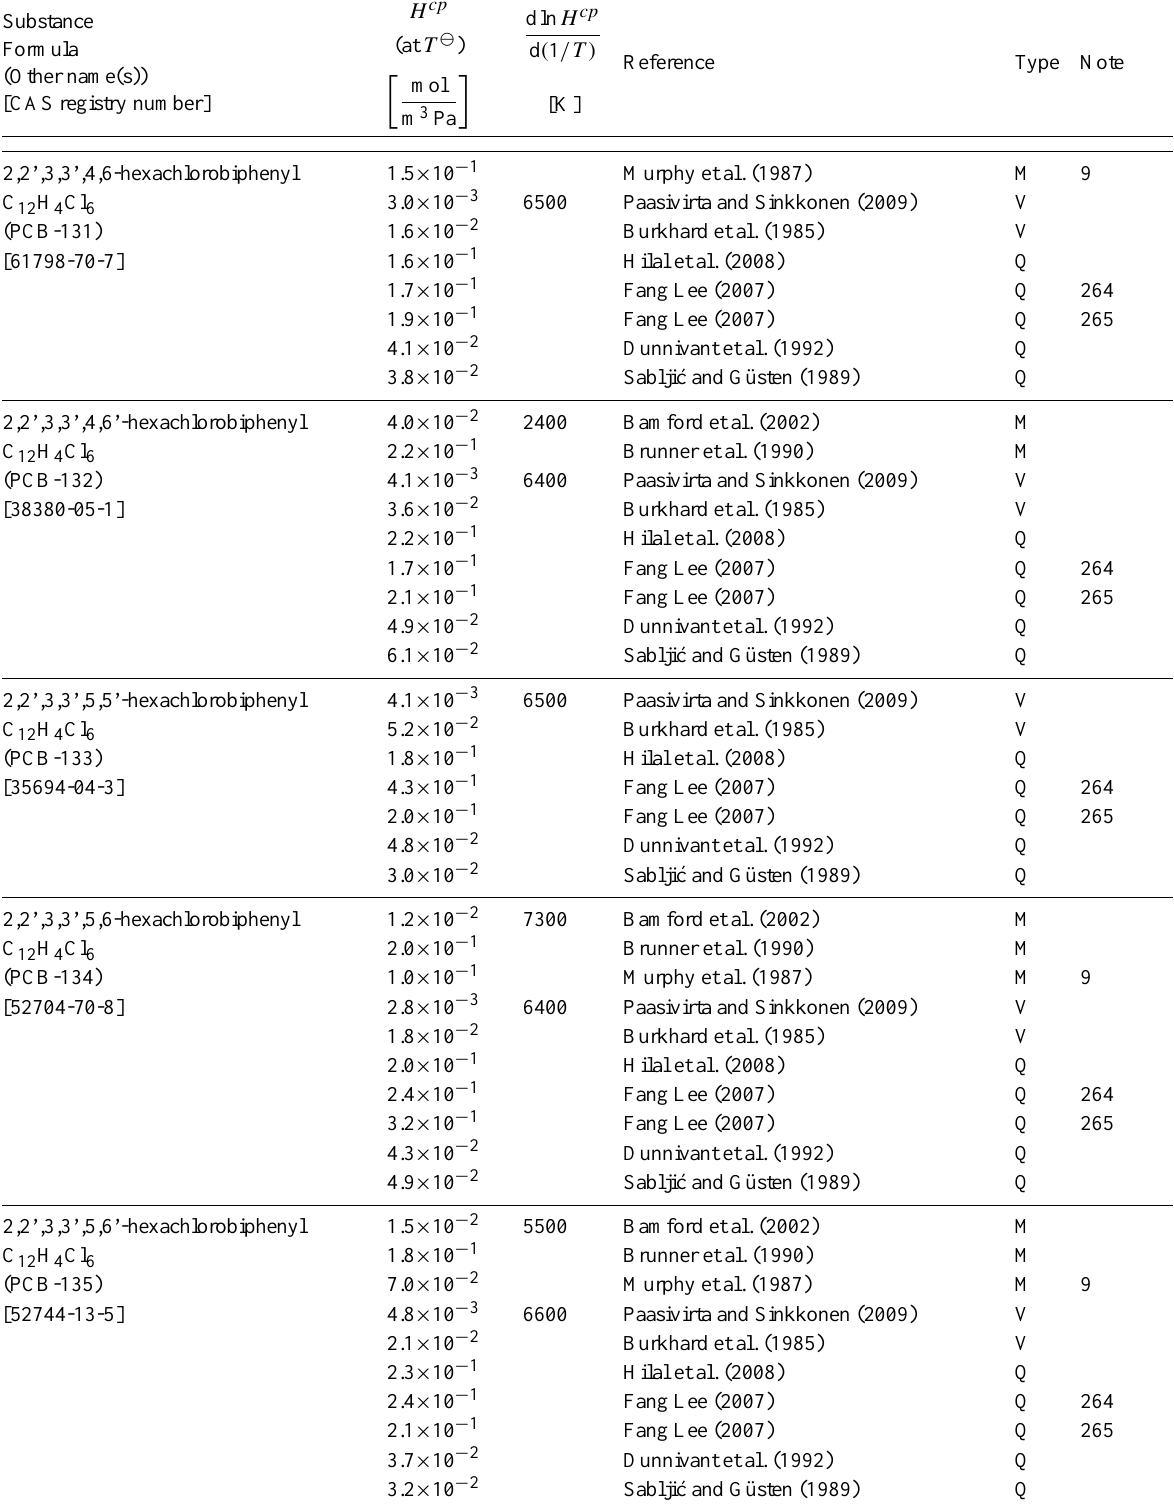
Table 6: Henry’s law constants for water as solvent